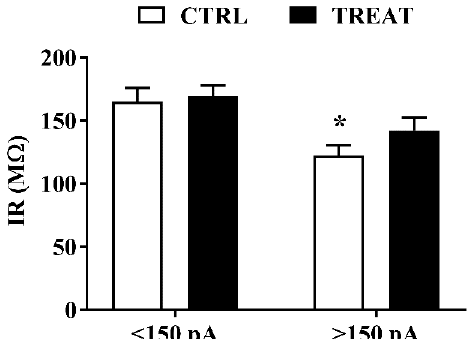
Figure 2. Creatine maternal supplementation affects input resistance in adult CA1 neurons . Neurons of treated rats excited by current injections above 150 pA do not show differences in input resistance compared to treated neurons excited by current injections below 150 pA, while such differences were found in neurons of control rats. Two-way ANOVA with Intensity of stimulation and Treatment (CTRL vs TREAT) as independent variables while the litter was considered as a blocking factor; Intensity : F (1, 42) = 14.69 p = 0.0004; >150 pA CTRL: n =11 neurons; TREAT: n = 11 neurons; <150 pA CTRL: n = 14 neurons; TREAT: n = 11 neurons. Sidak’s multiple comparisons test: <150 pA CTRL vs. >150 pA CTRL